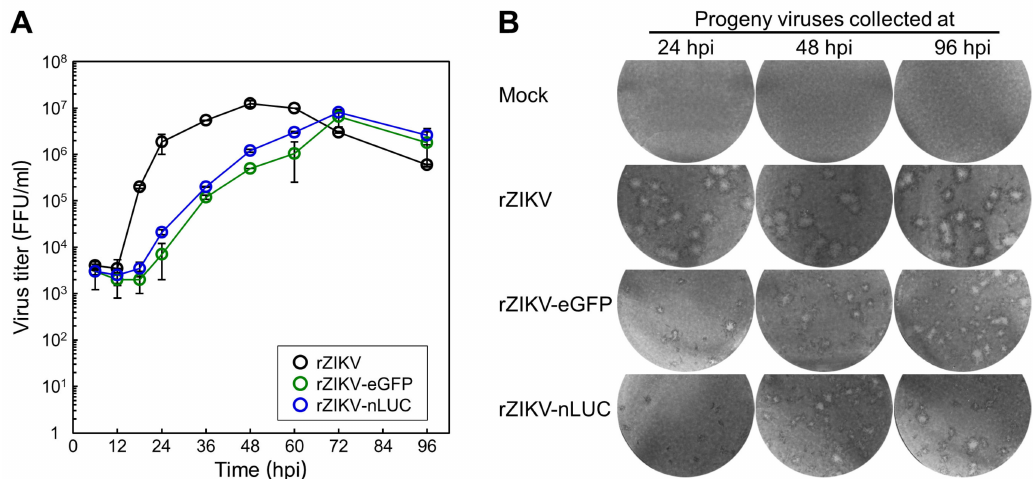
Figure 6. Characterization of viral growth and stability. BHK-21 cells were infected at a MOI of 1 with rZIKV, rZIKV-eGFP, or rZIKV-nLUC. ( A ) Viral growth. Culture supernatants were collected at the indicated time points after infection for 4 days to determine the accumulation level of infectious progeny virions by immunofocus assays on naïve BHK-21 cells. The data represent mean values, and the error bars show standard deviations. ( B ) Viral stability. Presented are representative images of the infectious foci formed by the infectious progeny virions that were harvested at 24, 48, or 96 h post-infection (hpi). Mock-infected cells were included as a negative